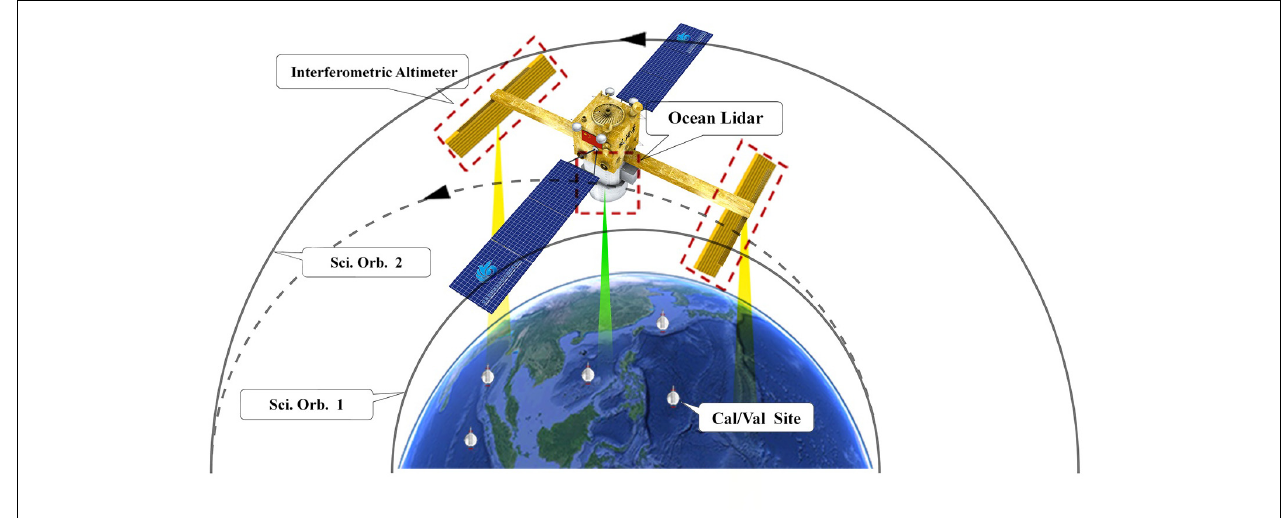
FIGURE 4 | The orbit configuration and payload system of the Guanlan mission.